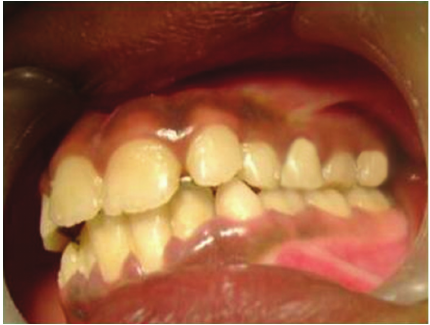
Figure 4: Lateral intraoral view following correction of anterior crossbite and posterior crossbite on the left side.